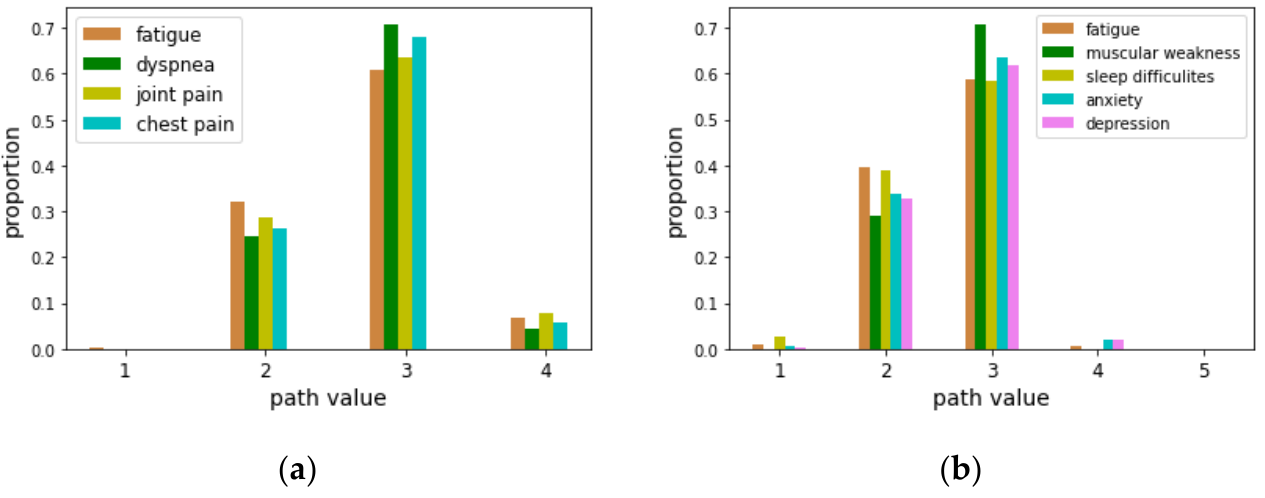
Figure 4. ( a ) Path values and proportions of COVID-19 genes and different symptom genes in Europe. ( b ) Path values and frequencies of COVID-19 genes and different symptom genes in China. The x-axis represents the different path values, the y-axis represents the proportion of the path values. The maximum length of the path between the SCRGs and the LCSIGs in both Europe and China was not more than 5, and most path values were 2 and 3, indicating that these long-COVID symptoms are closely related to COVID-19 at the genetic level. Table 2. Maximum value of the shortest path in each module. The maximum value of the shortest paths in most modules was 3 or 4, and only the value of the anxiety and depression gene modules reached 5 and 6, indicating that the gene connection in most modules was relatively strong. 6 Table 3. ( a ). Path module correlation coefficient between the European SCRGs module and the cor- responding LCSIGs module. The rank of the path module correlation coefficient calculated by us is basically consistent with the rank of the long-COVID symptoms frequency described in the paper [24], except for the symptom of dyspnea. ( b ). Path module association coefficient between the Chi- nese SCRGs module and the corresponding LCSIGs module. The path module correlation coeffi- cients of combined fatigue and muscle weakness symptoms genes and the COVID-19 genes and combined anxiety and depression symptoms genes and the COVID-19 genes were determined. The rank of the path module correlation coefficients is completely consistent with the rank of the long- COVID symptoms’ frequency described in the paper [24 ]. ( a ) Coefficient